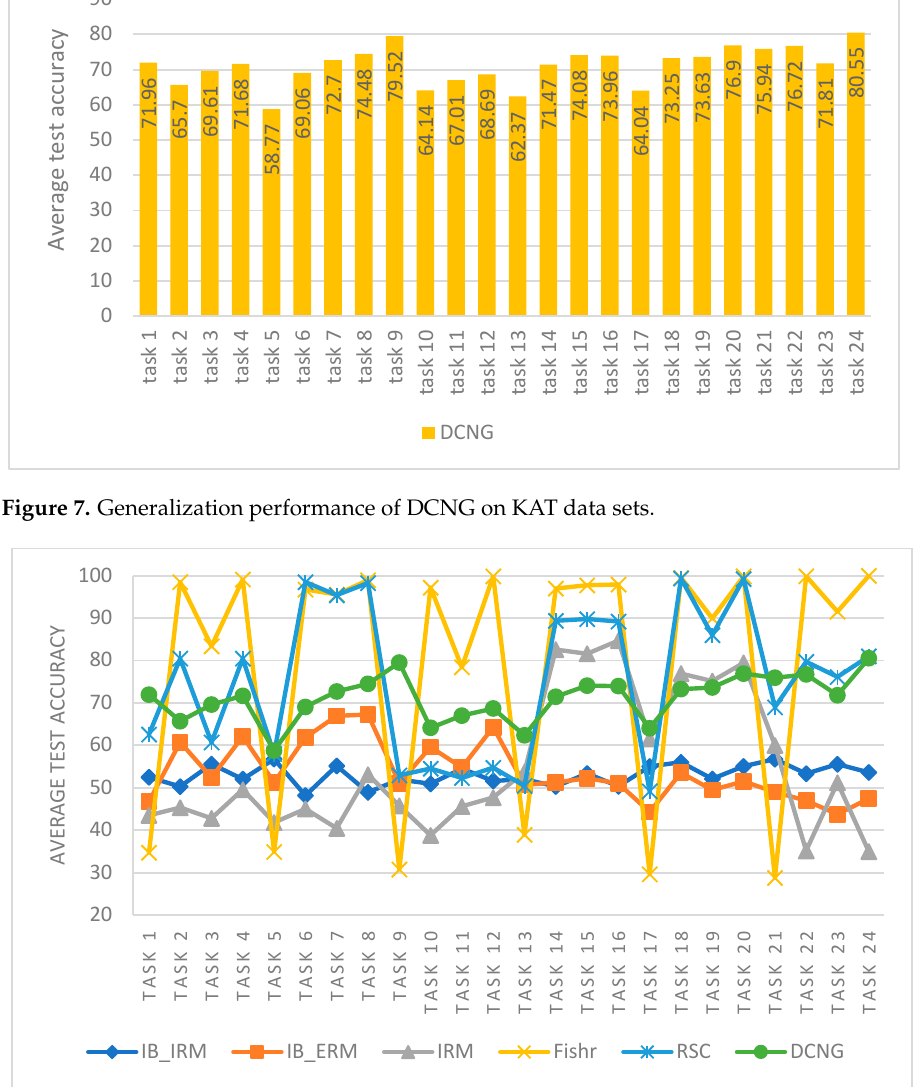
Figure 9. The influence of different parameter settings on the DCNG model in the CWRU data set. Table 5. Different parameter settings on the CWRU data set. Parameter Settings